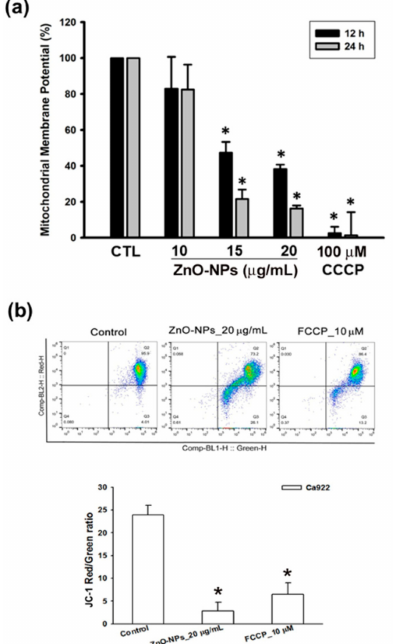
Figure 4. E ff ects of ZnO-NPs on mitochondrial membrane potential of human GSCC cells. ( a ) Ca9-22 cells were treated with ZnO-NPs (10–20 µ g / mL) and carbonyl cyanide m-chlorophenyl hydrazone (CCCP) (100 µ M) for the indicated times to determine the change of mitochondrial membrane potential using MITO-ID assay kit. ( b ) Flow cytometry analysis showed the gating of JC-1 (red) aggregates and JC-1 (green) monomer populations in Ca9-22 cells treated with ZnO-NPs and carbonyl cyanide-4-(trifluoromethoxy)phenylhydrazone (FCCP) for 24 h. Ratio of JC-1 staining represents the mitochondrial function. Data are expressed as mean ± SEM of four independent experiments. * p < 0.05 compared with control